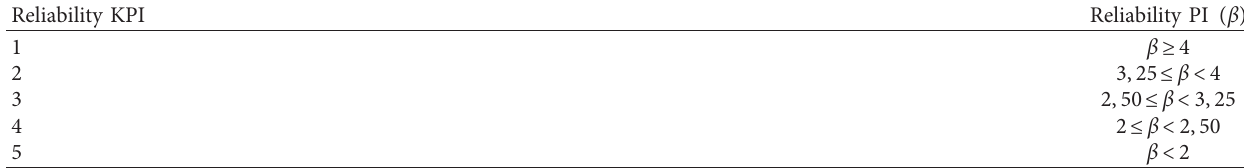
Table 2: Correlation between reliability KPI qualitative scale and reliability index ( β ) PI quantitative scale, adapted from [33]. Reliability KPI